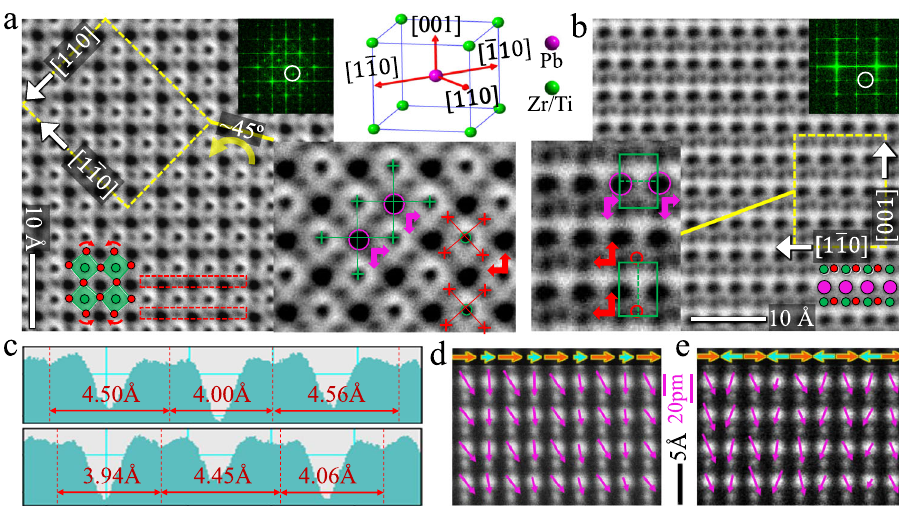
Fig. 3 Atomic-scale characterization within antiphase domain in PZTN97/3. a , b The atom-resolved ABF images acquired within antiphase domain along [001] p and [110] p direction, respectively, where their fast Fourier transforms (FFTs) are inserted in upper-right corner. Their FFTs clearly show the M-points as marked by white circles. The magni fi ed images of yellow boxes directly visualize the displacement of Pb (magenta) and oxygen octahedra (red) relative to average position of Zr/Ti (green) atomic positions. The illustration locating between a and b acts as a guideline for easily referring to lattice vectors. c Measurements of O-O distance derived from red rectangle boxes in a showing tilts of oxygen octahedra. d , e Two types of Pb modulated displacement (magenta arrows). The displacement vectors are overlaid on atomic-resolved HAADF images along [110] p direction, where horizontal components associated with M-type superlattice re fl ection are highlighted with orange and cyan arrows.